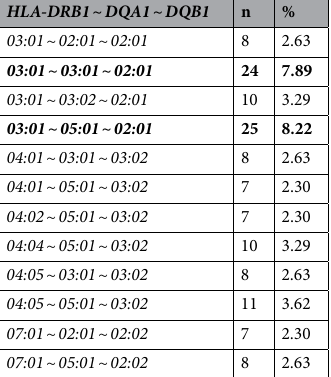
plementary Table 5S online. The HLA-DQA1 alleles 03:01, 03:02, 05:03 , and 05:05 showed an OR of risk for association with T1D, while the DQA1*01:01 , 01:02 , 01:03 , and 04:01 alleles revealed an OR of protection for T1D (Supplementary Table 5S online). The HLA-DQB1*02:01 , 03:02 and 03:19 alleles showed an odds ratio of risk for association with T1D, while the 03:01, 03:03, 04:02, 05:01, 05:03, 06:02, and 06:03 alleles showed an OR of protection for T1D (Supplementary Table 5S online). Supplementary Table 6S online shows the distribution of the HLA- DRB1- DQA1 , and -DQB1 alleles in patients with T1D according to Y chromosome ancestry. The European Y chromosome showed a higher fre- quency of DRB1*03 and DRB1*04 , while the DRB1*01 and DRB1*16 were the most frequent in the Native American Y ( P < 0.001). For European Y, the most frequent categories were DQA1*03:01 and 05:01 , while for Native Americans, it was 01:01 . In the European and African Y ancestries, the highest frequencies were observed for DQB1* 02:01 and 03:02 , while for Native American, the highest frequency was 05:01 . There were significant differences in the distribution of the DRB1*/DRB1* genotype between Y chromosome category ( P = 0.015). The data showed that DRB1*03 and DRB1*04 homozygote genotypes were detected only in European Y. The frequency of DRB1*03 and DRB1*04 homozygote genotypes and DRB1*03/DRB1*04 heterozy-